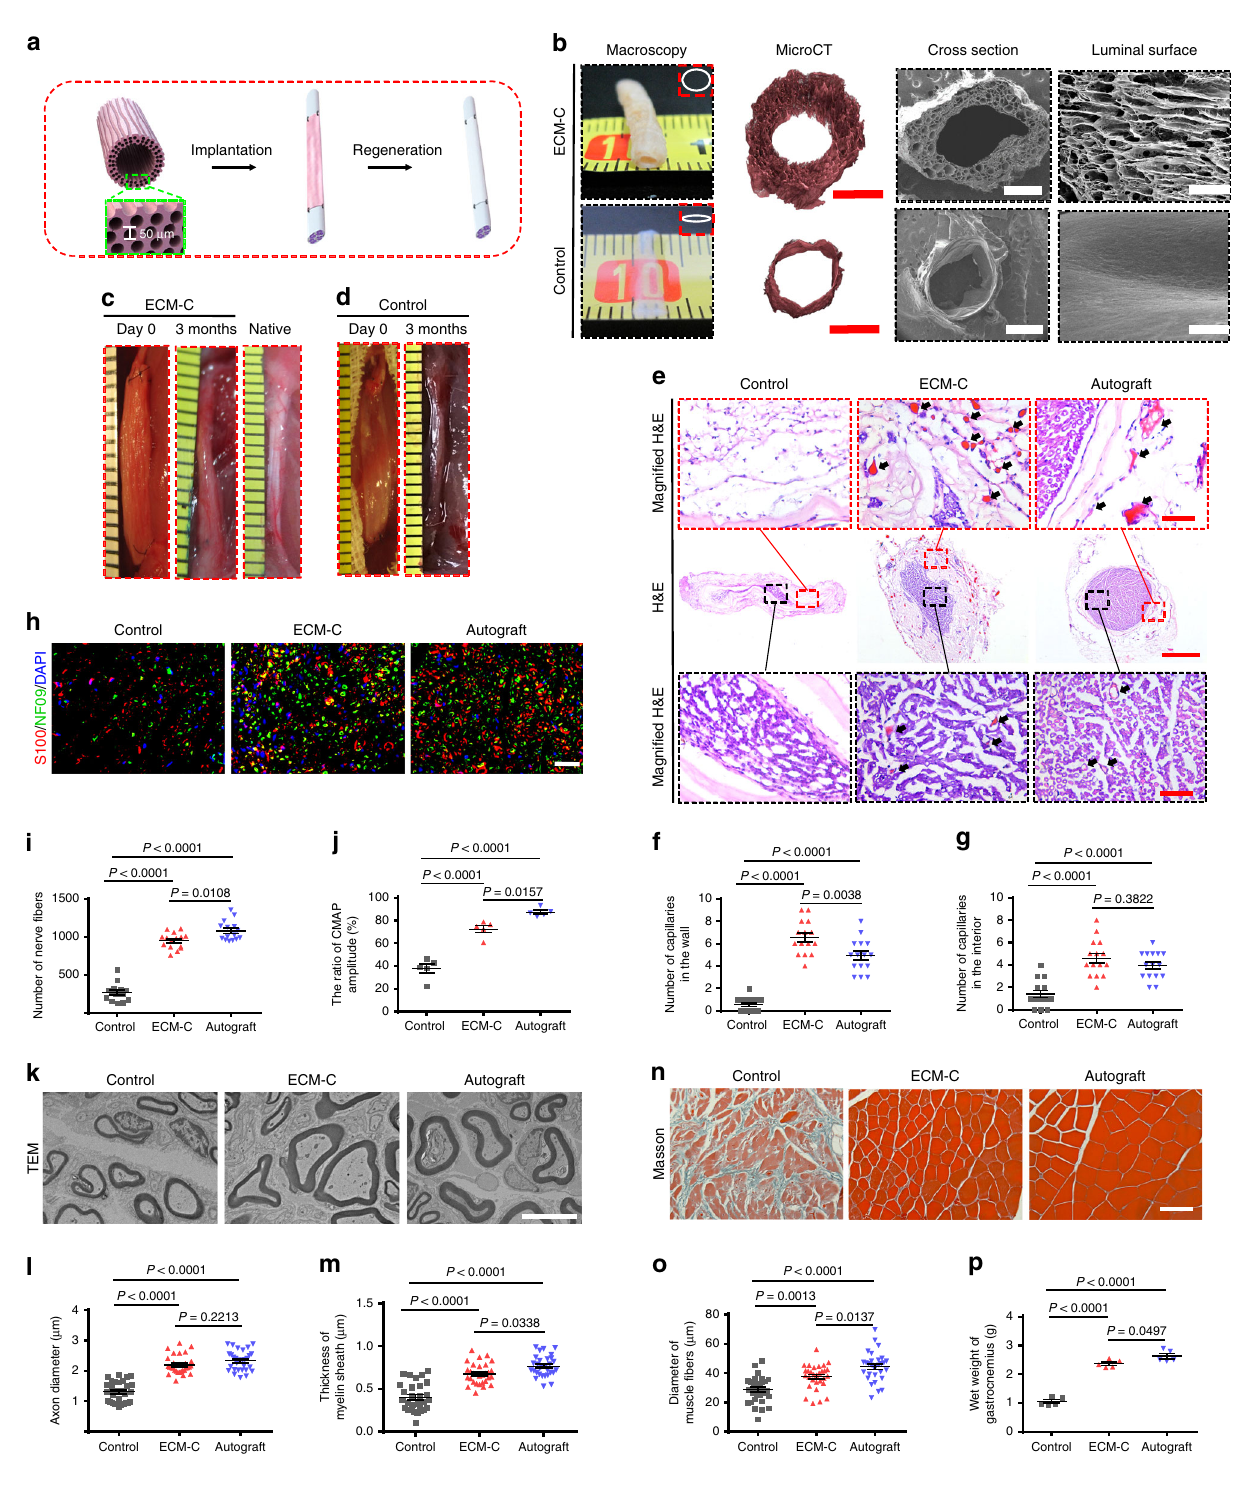
saphenous veins (1680 ± 307 mm Hg), the most commonly used autografts for coronary artery bypass surgery 35 . Good morphol- ogy preservation was observed with the vascular ECM-C (about 6 cm in length), i.e., no kinking occurred upon bending to 180° (Fig. 7b). MicroCT examination of such ECM-C revealed even distribution of circumferentially aligned microchannels within the wall. In contrast, control scaffolds (formed on the solid sili- cone rods) were only thin conduits without pores (Fig. 7c, Sup- plementary Fig. 8a, b, Supplementary Movie 5 and 6).